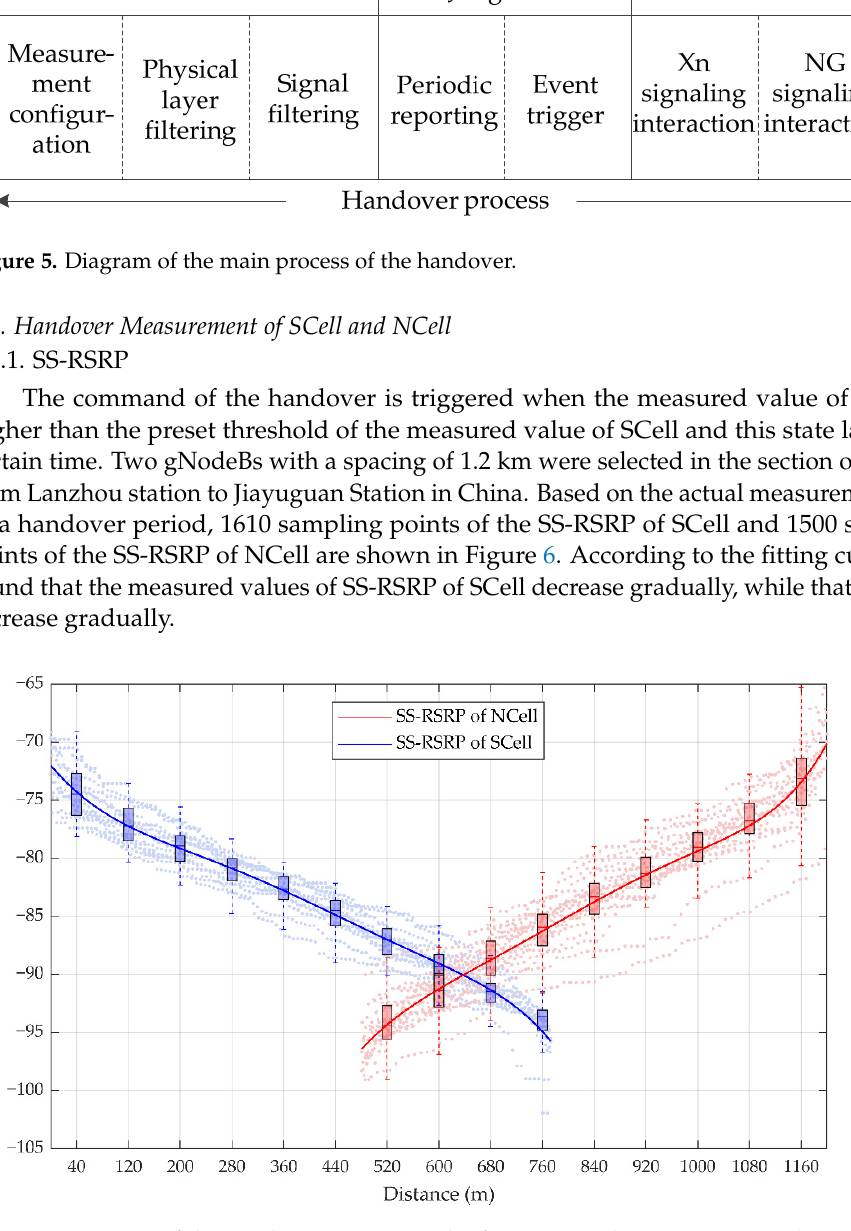
Figure 6. Statistics of the synchronization signal reference signal receiving power (SS-RSRP) meas- urement. The box plots represent the statistic of SS-RSRP in each 80 m: For a certain box, the bot- tom is the lower quartile Q1, the top is the upper quartile Q3, the horizontal line in the middle of the box is the median Q2; the top of the whisker is O3 + 1.5IQR, and the bottom is Q1 – 1.5IQR, where IQR is the interquartile range IQR = Q3 − Q1.